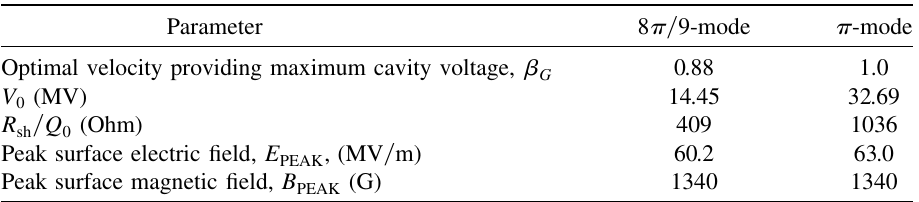
TABLE III. Parameters of ILC cavity for 8 (cid:1)= 9 - and (cid:1) -modes. Parameter